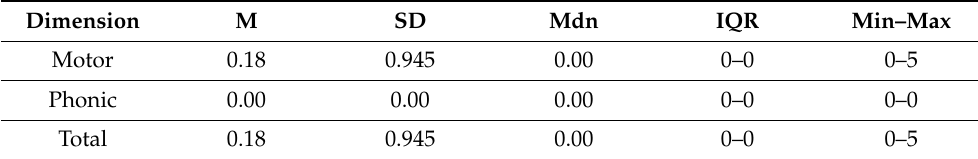
Table A13. Scores in the Adult Tic Questionnaire (ATQ) of healthy control subjects ( n = 28). Abbre- viations: IQR, interquartile range; M, mean; Max, maximum; Mdn, median; Min, Minimum; SD, standard